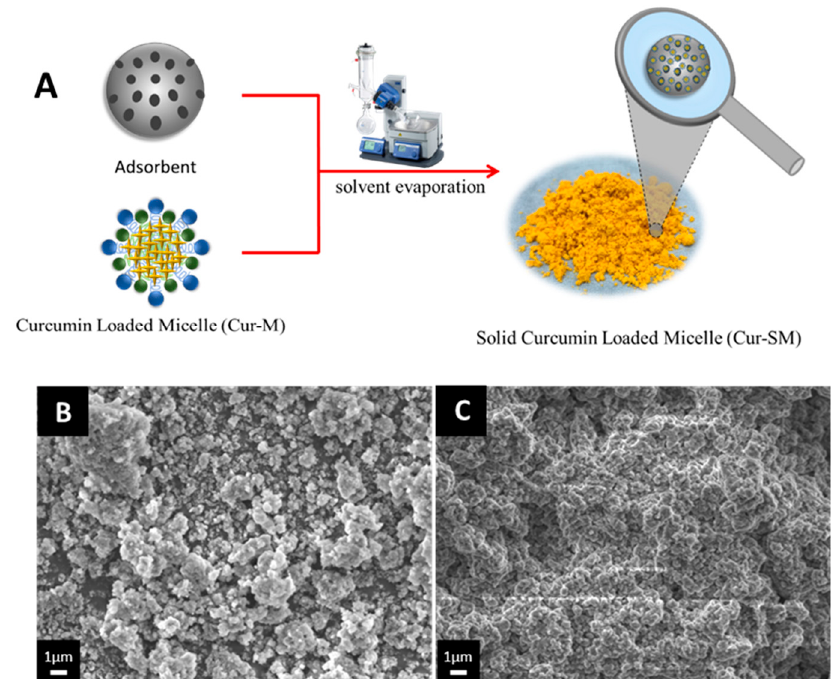
Figure 5. ( A ) Schematic illustration of preparation of the Cur-SM. ( B ) Scanning electron microscopy (SEM) images of the adsorbent (Neusilin US2) and ( C ) curcumin-loaded self-assembled micelles (Cur-SM). Images were acquired by placing powder samples on a graphite surface and coated with gold by an ion-sputter coater.